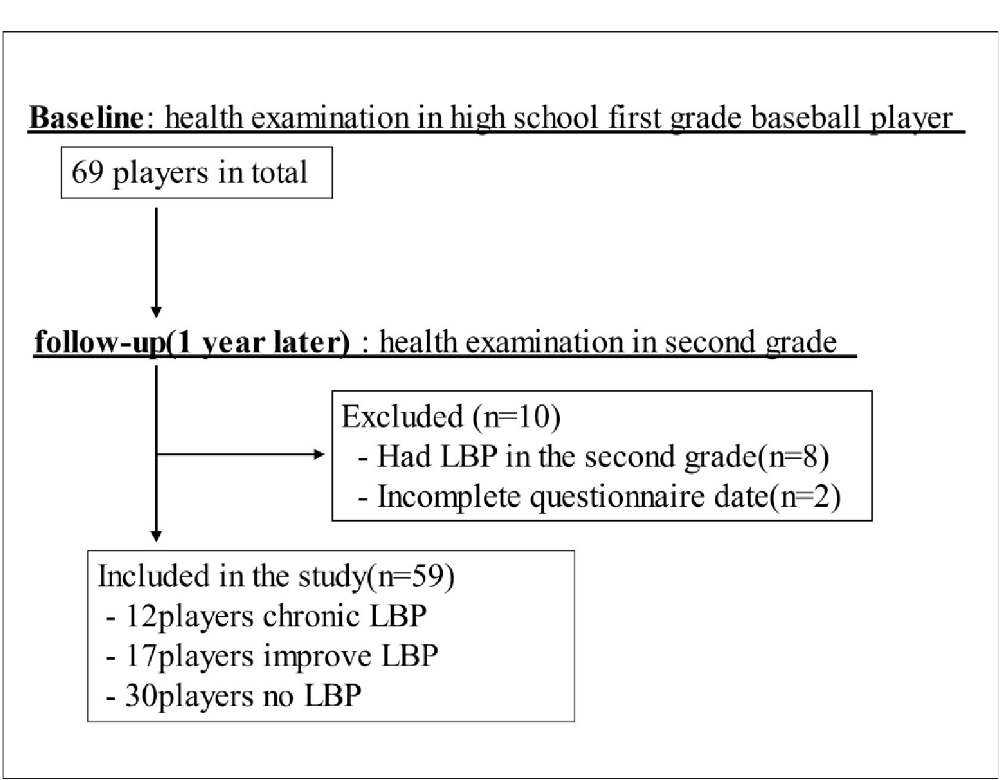
Fig 1. Flowchart of the participants’